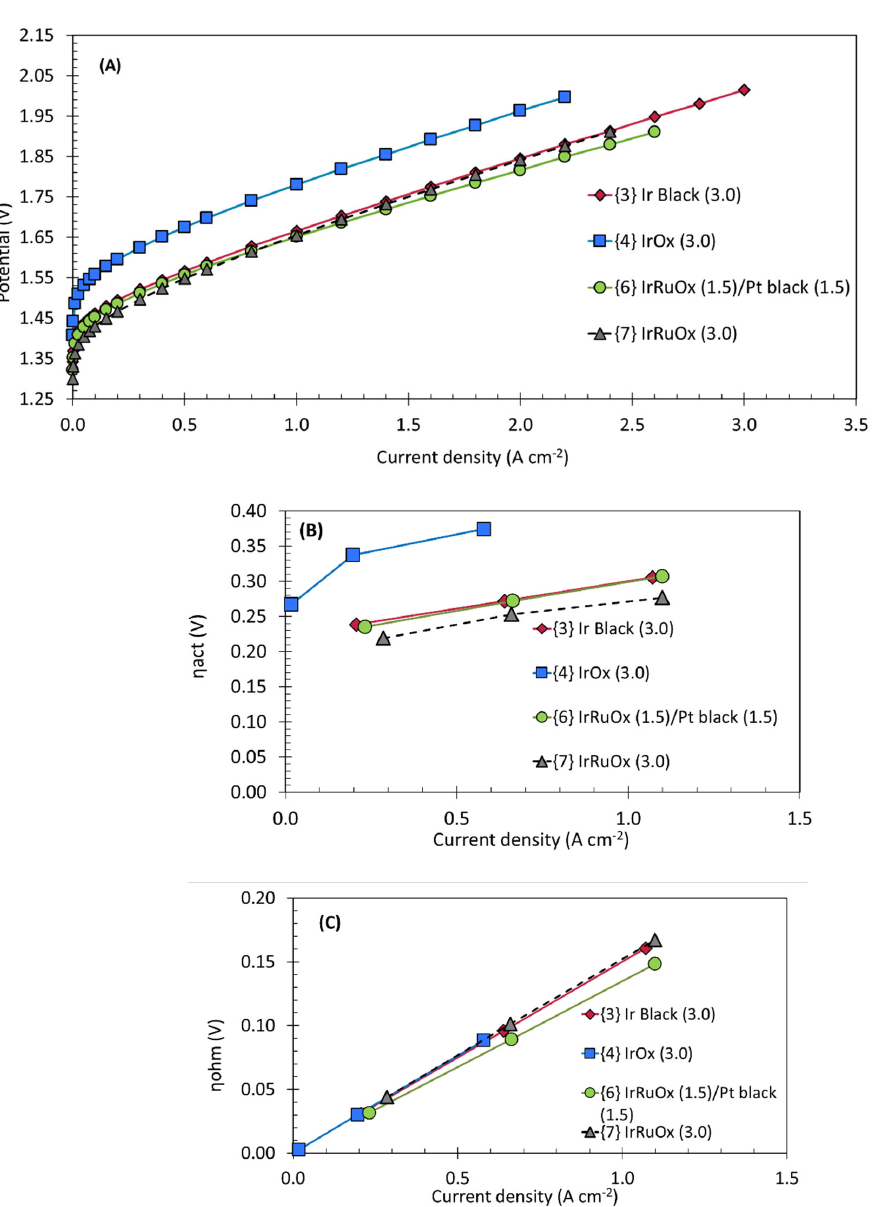
Figure 5. Data of CCMs with different anode catalyst operating at 80 °C. ( A ) ‐ I ‐ V curves, ( B ) ‐ activation overpotentials, ( C ) ‐ ohmic overpotentials.